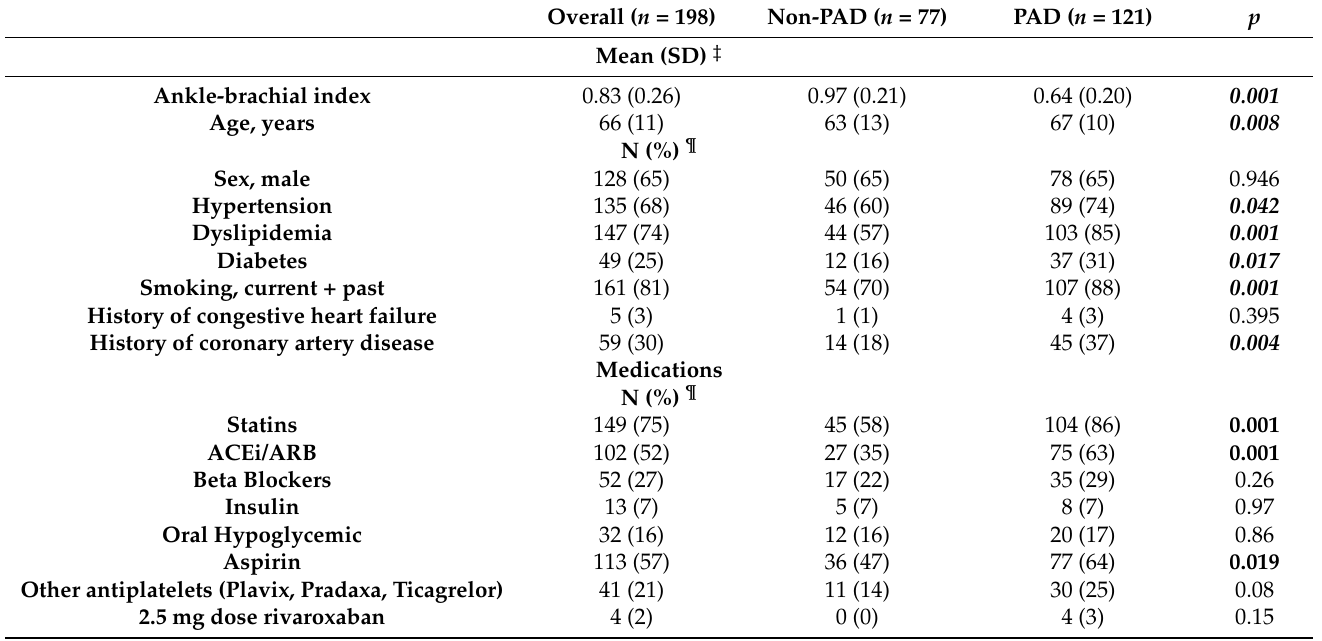
Table 1. Demographic and clinical characteristics of patients with and without peripheral artery